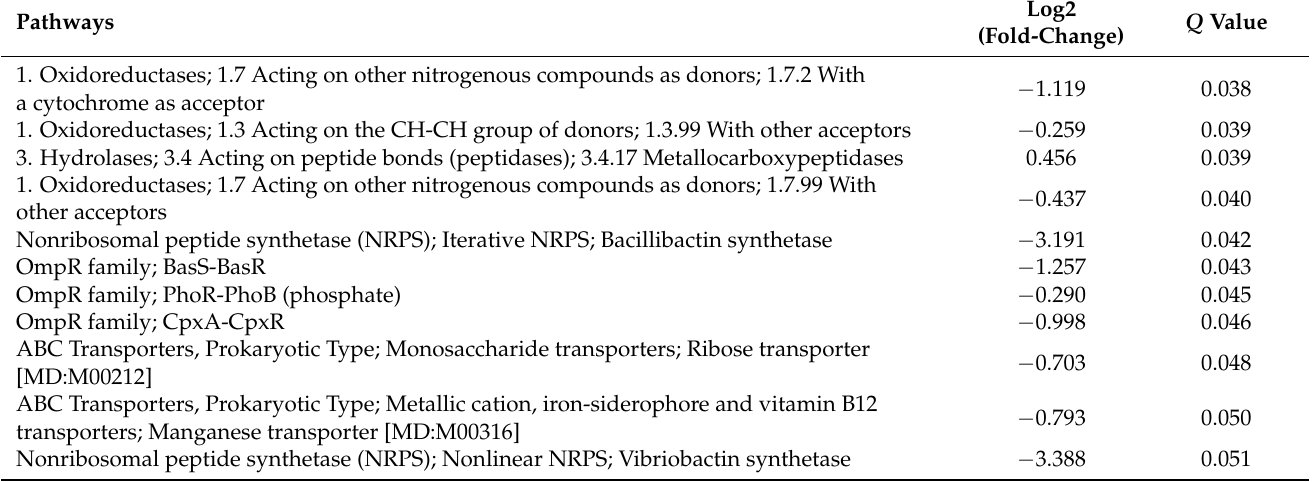
abundance (Table S20), enzyme levels (Table S21), and KEGG pathway analysis (Table S22). Table 5. Day 30 comparison of the Pathways (KO level 3) of subjects demonstrating UV resistance following grape consumption ( n = 9) vs. subjects not resistant to UV irradiation following grape consumption ( n = 20).